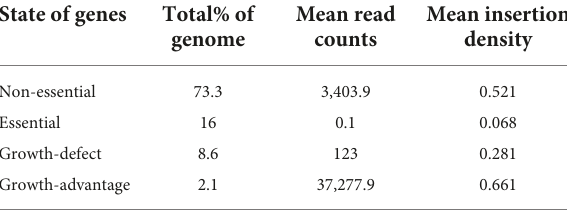
TABLE 2 State identification